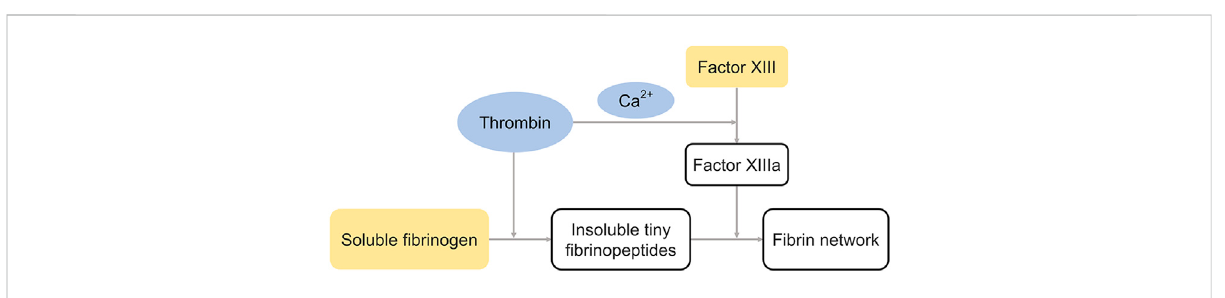
FIGURE 4 The cross-linking process of fi brin glue. Thrombin catalyzes the formation of insoluble tiny fi brinopeptides and factor XIIIa, and factor XIIIa catalyzes the transformation of fi brinopeptides to fi brin network. The blue and yellow represent components in different